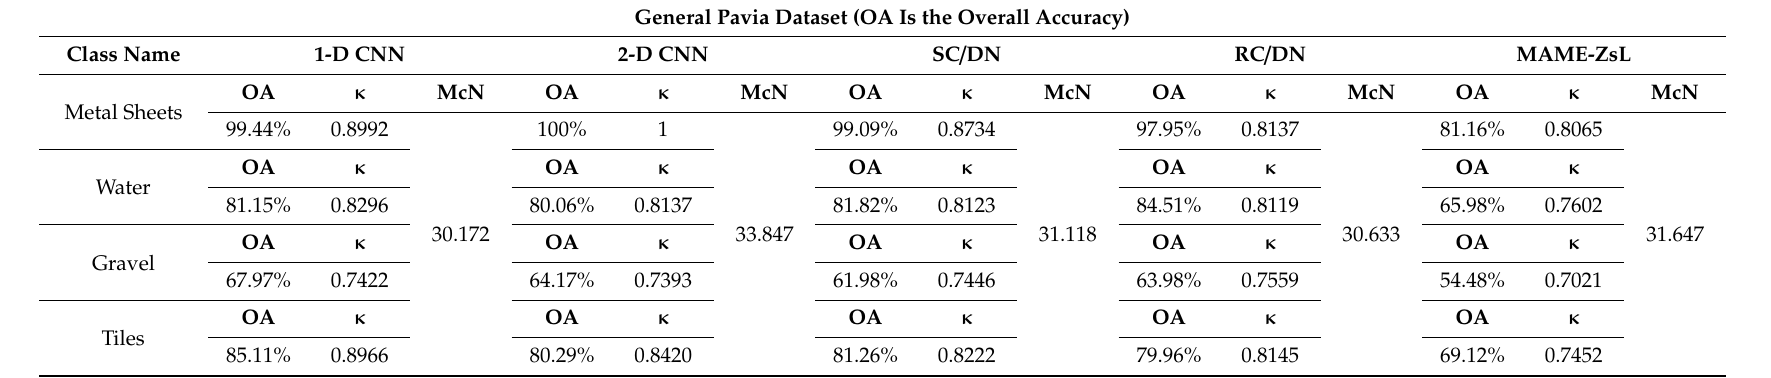
Table 8. Testing classification accuracy and performance